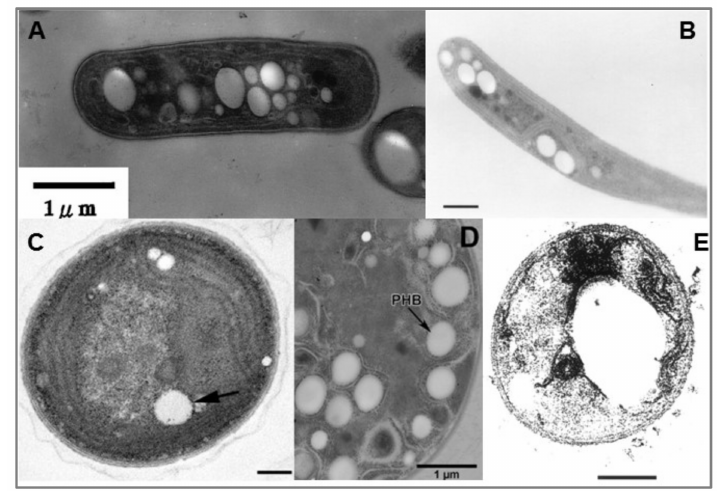
Figure 6. PHB granules inside the cyanobacteria cells: ( A ) Synechococcus sp. PCC7942 [27]; ( B ) Synechococcus sp. PCC7942 [97]; ( C ) Synechocystis PCC6803 [23]; ( D ) Cyanothece sp. strain PCC 7822 [98]; ( E ) Synechococcus sp. MA19